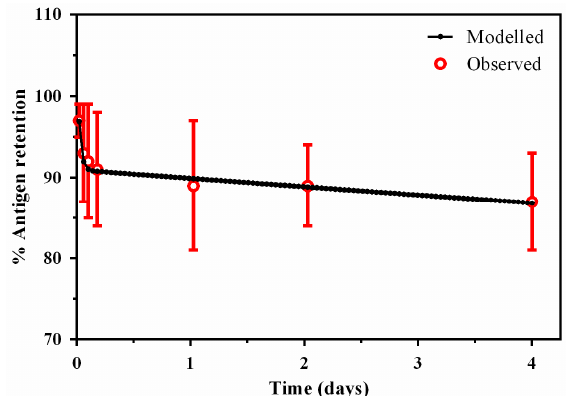
Figure 3. Compartmental modelling estimates for: ( A ) liposome and ( B ) antigen at the muscle.